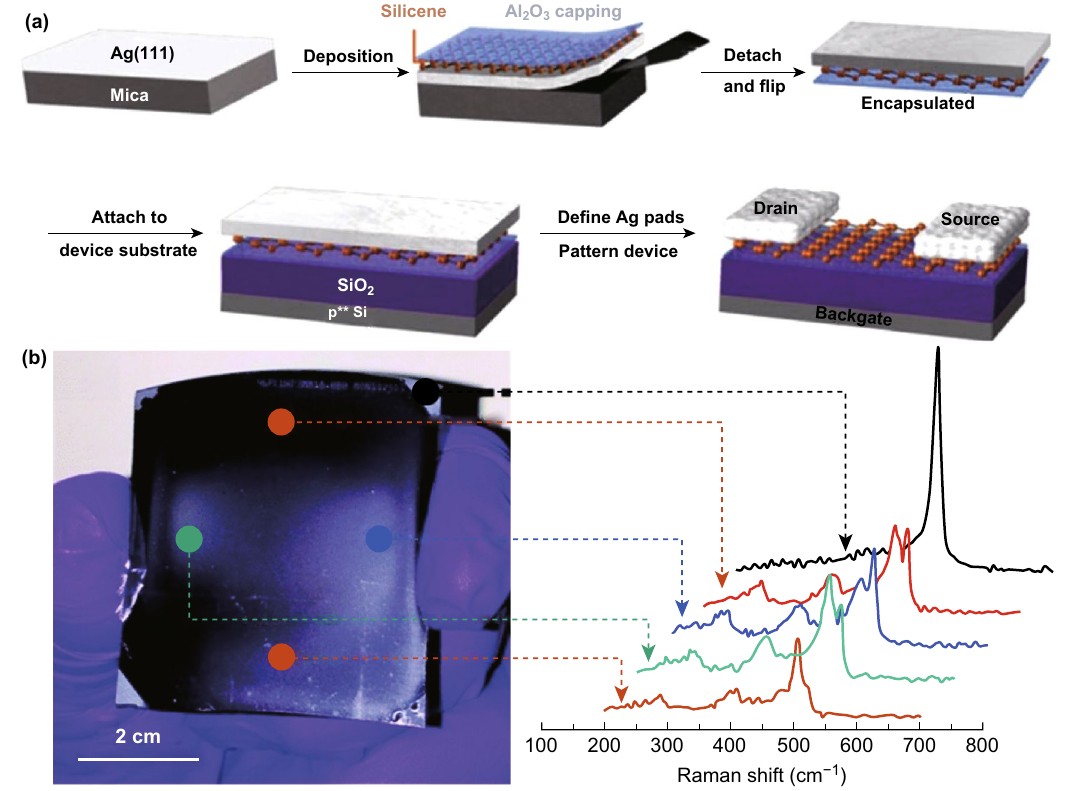
Fig. 7 Large-area synthesis of 2D Xenes. a Schematic representation of the synthetic steps for the synthesis of silicene including epitaxial depo- sition, Al 2 O 3 capping, transfer onto a substrate and device fabrication. Adapted with permission from Ref. [105]. Copyright 2016, Elsevier B.V. b Large-area synthesised multi-layered germanene using N 2 plasma assisted-process and corresponding Raman spectra at multiple locations. Adapted with permission from Ref. [101]. Copyright 2015, Royal Society of Chemistry Publishing